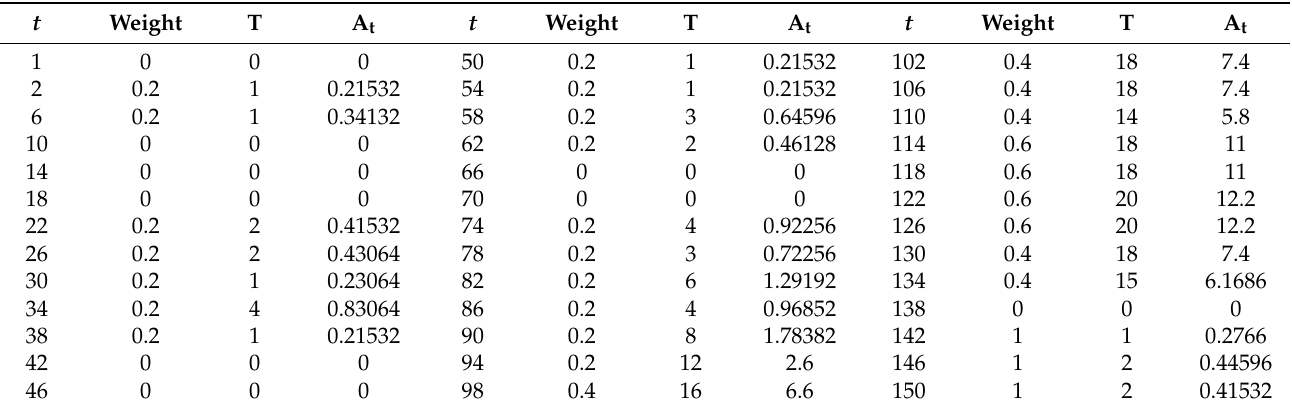
Table 7. Aggregate situation